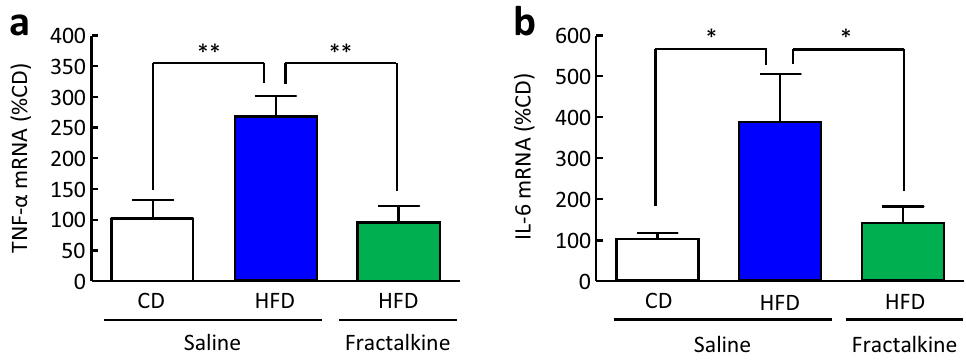
Figure 6. Effects of intracerebroventricular administration of fractalkine on mRNA expression of TNF-αand IL-6 in the hypothalamus of mice fed a HFD. ( a ) TNF-α and ( b ) IL-6 mRNA expression in the hypothalamus of mice fed a CD or HFD for 16 weeks at 3 h after intracerebroventricular administration of fractalkine. Results are expressed as mean ± SEM for 6–15 mice. Significant difference: * P < 0.05, ** P <